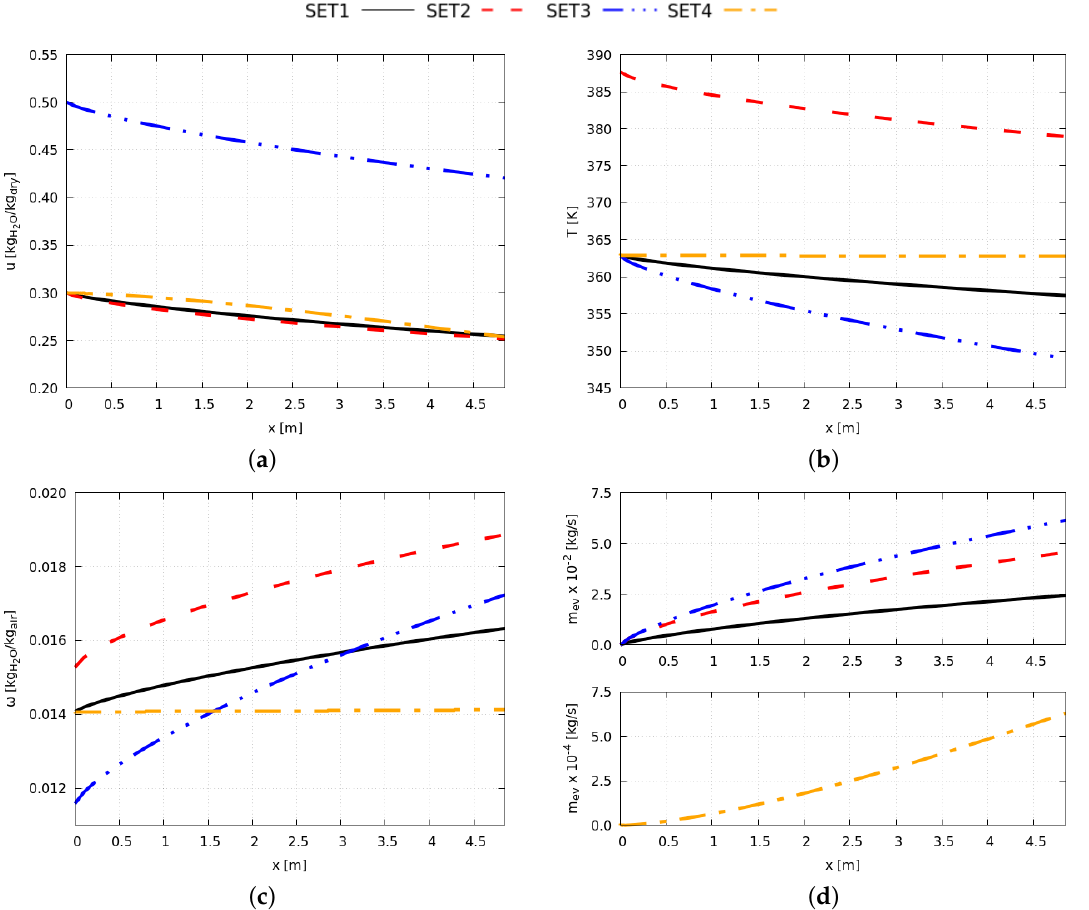
Figure 11. Moisture content of the product ( a ), air temperature ( b ), absolute humidity ( c ), and cumulative evaporation rate ( d ) along the bed